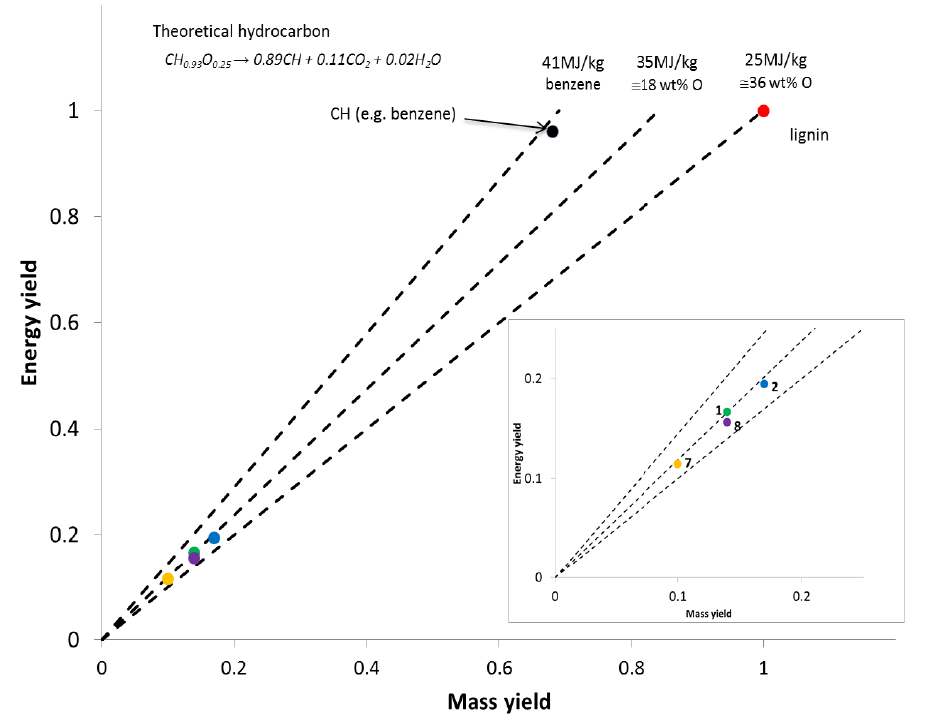
Figure 3. Funnel Plot of lignin pyrolysis indicating the effect of feedstock composition on energy efficiency.